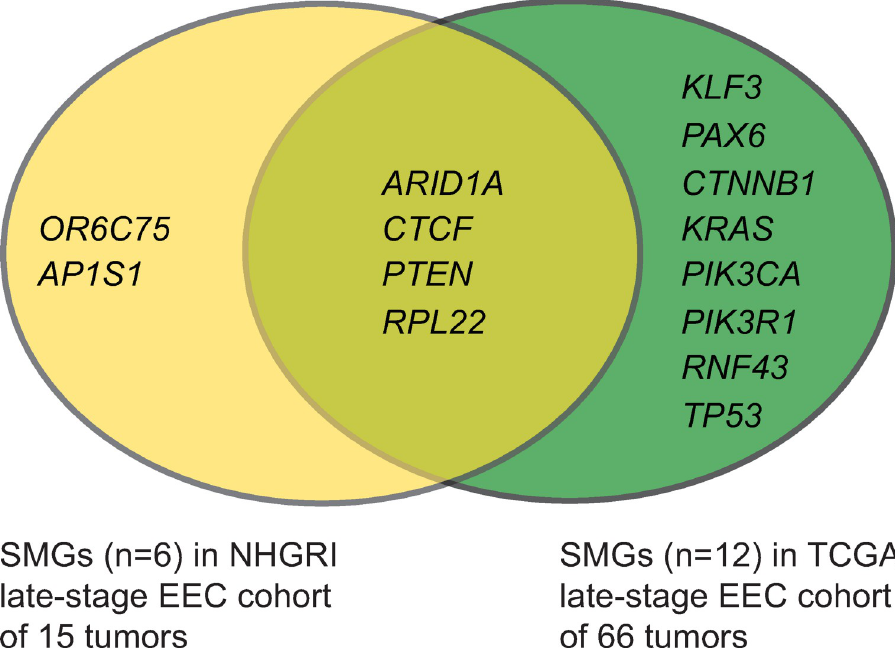
Fig 2. Statistically significantly mutated genes (SMGs) in late-stage EEC cohorts. Venn diagram showing gene names for SMGs identified by MutSigCV (v1.4) analysis of 15 NHGRI late-stage EECs and 66 TCGA late-stage EECs. Late-stage tumors were defined as stage III or stage IV tumors. SMGs are defined as genes mutated in a tumor cohort at statistically significantly (q-value � 0.10) higher rates than the background mutation rate.